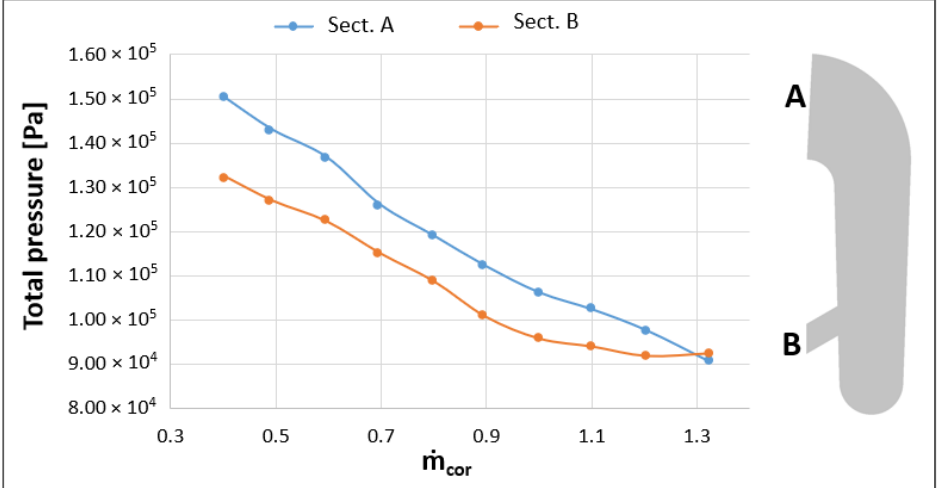
Figure 10. Distribution of the total pressure at sections A and B by varying the operating condition—nominal rotational speed.